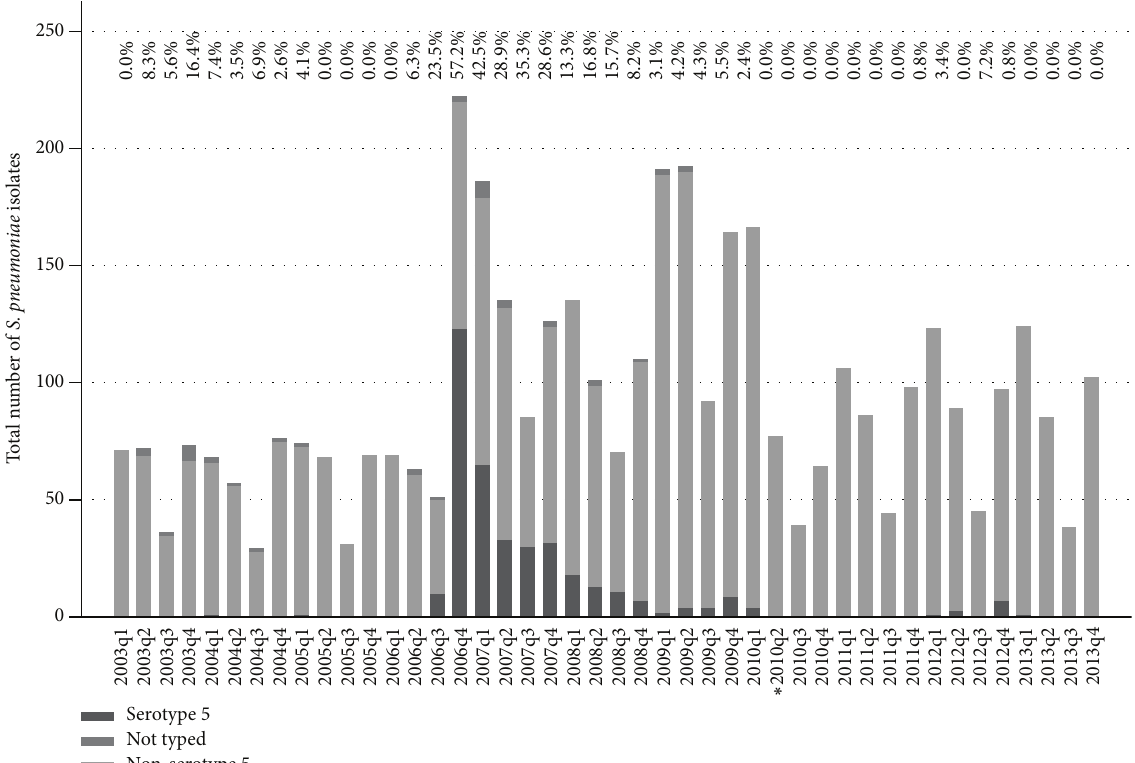
Figure 1: Quarterly prevalence of serotype 5 pneumococcal IPD in British Columbia. Numbers above bars are % serotype 5 isolates per quarter. ∗ is introduction of PCV13; q: quarterly (i.e., three-month